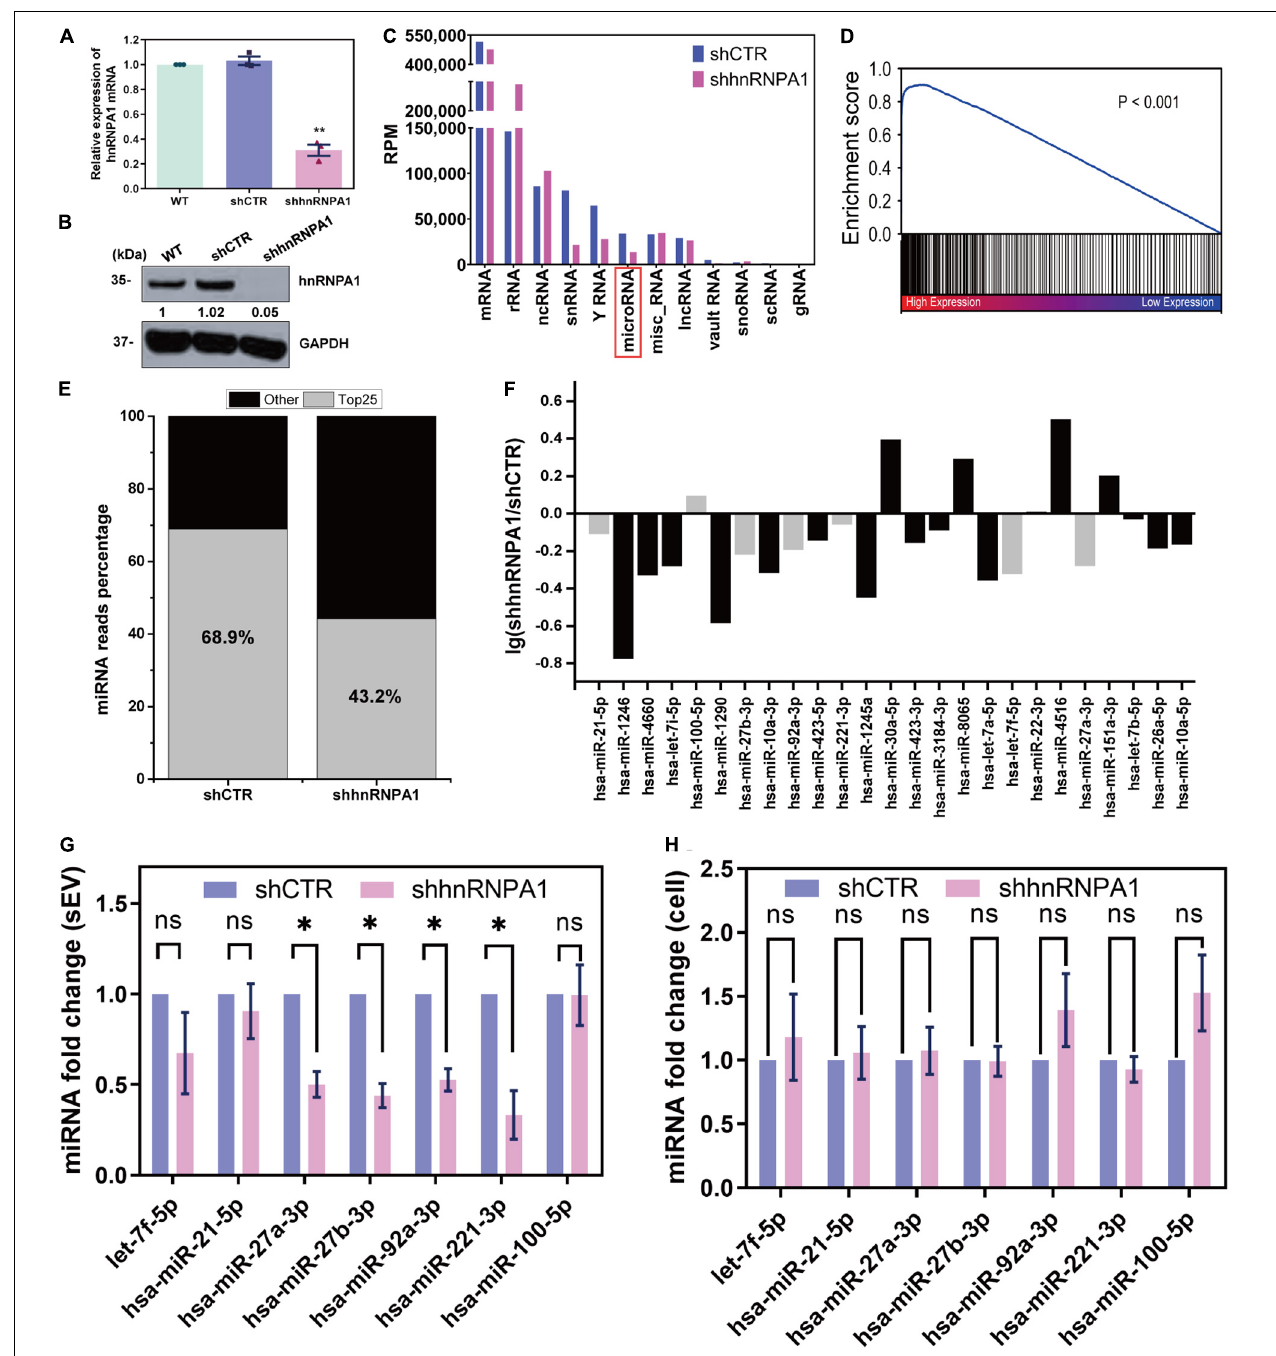
FIGURE 3 | HnRNPA1 is a powerful sEV-miRNA loading protein. (A) RT-qPCR analysis of mRNA levels after knockdown of hnRNPA1 in A549 cells. (B) Western blotting analysis of protein level in shhnRNPA1 A549 cells. (C) RPM of different small RNA components in sEVs derived from shhnRNPA1 and control (shCTR) cells. (D) Enrichment analysis of the downregulated sEV-miRNAs after knockdown of hnRNPA1. X-axis: 2,585 expressed sEV-miRNA ranked by the expression level. Black lines (enriched in high expression region) represent downregulated sEV-miRNAs and white lines represent upregulated sEV-miRNAs. (E) Percentage of the top 25 highly expressed sEV-miRNAs derived from shCTR and shhnRNPA1 cells. Gray areas represent the top 25 miRNAs, and black areas represent other miRNAs. (F) Bar chart showing the alteration of top 25 highly expressed sEV-miRNAs after knockdown of hnRNPA1. MiRNAs indicated by gray bars were selected for the following RT-qPCR. RT-qPCR analysis of the relative expression levels of the selected miRNAs in shhnRNPA1 sEVs (G) and in shhnRNPA1 cells (H) . The significant differences were reported for three independent experiments (ns, no significance; ∗ p < 0.05; ∗∗ p < 0.01, two-tailed t -test). hnRNPA1, heterogeneous nuclear ribonucleoprotein A1; sEV-miRNA, microRNA in small extracellular vesicle; RPM, reads per million.